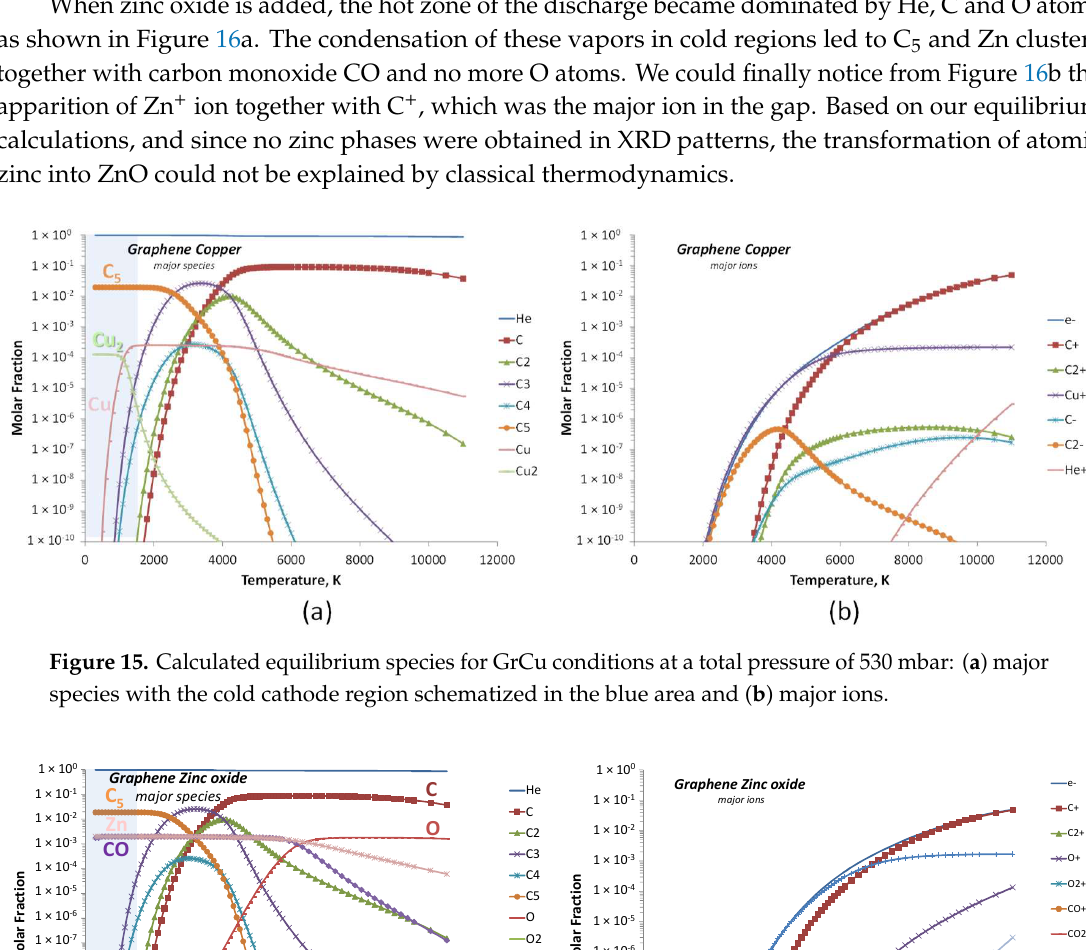
Figure 16. Calculated equilibrium species for GrZnO conditions at a total pressure of 530 mbar: ( a ) major species with the cold cathode region schematized in blue area and ( b ) major ions.